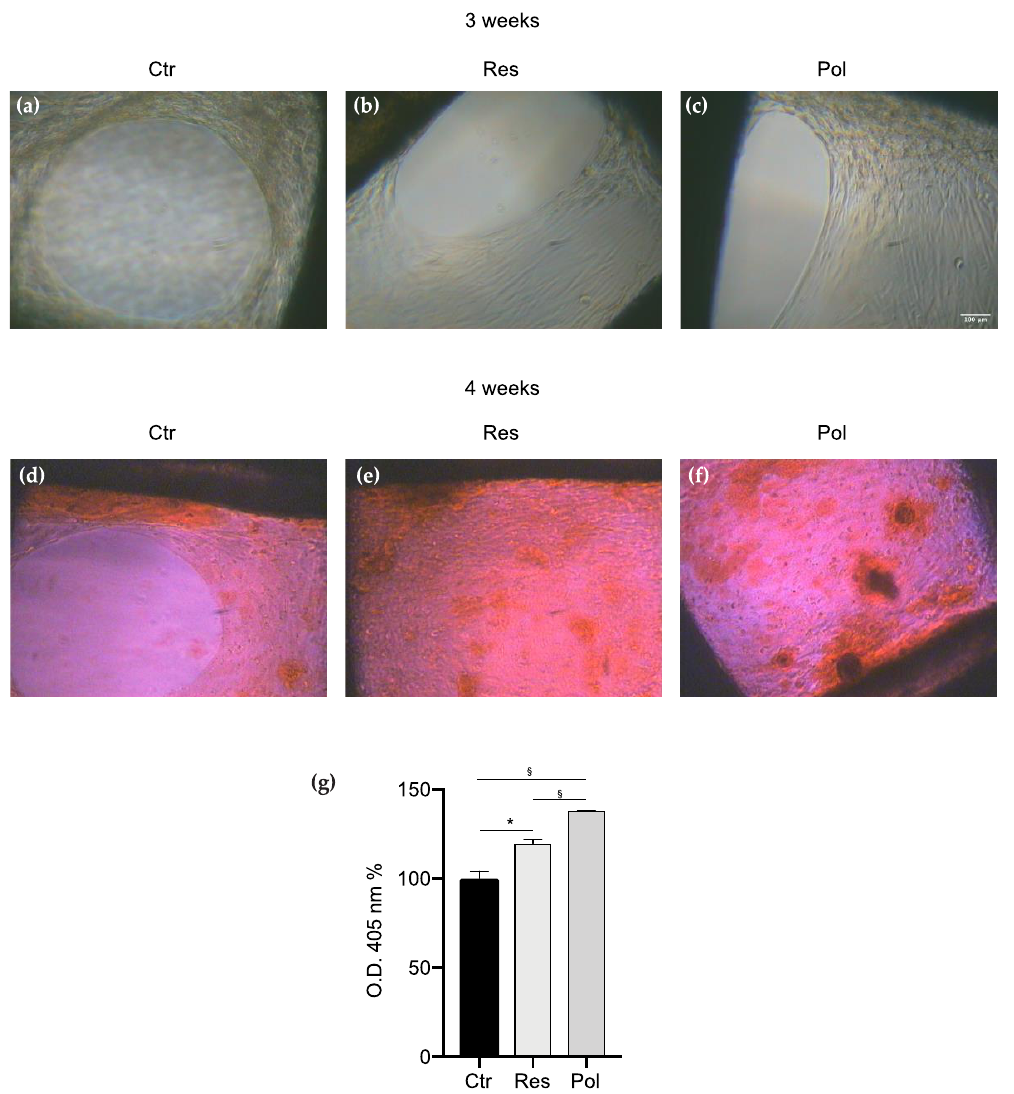
Figure 3. DBSCs proliferation and mineral matrix deposition on medium pore scaffolds. ( a – c ) Representative phase contrast pictures of DBSCs treated with Res, Pol or Ctr for 21 days in osteogenic conditions on scaffolds presenting pores of medium dimensions (0.9 mm). Scale bar = 100 μm. ( d – f ) ARS (Alizarin red staining) displayed mineral matrix deposition by DBSCs after 28 days of culture. ( g ) The graph shows ARS quantification using the optical density (OD) as mean percentage ± SD and is representative for three independent experiments performed in quadruplicates. § p < 0.01, * p < 0.001. Student’s t -test was used for single comparisons. The biomaterial pores of a representative experiment were chosen for the figure.